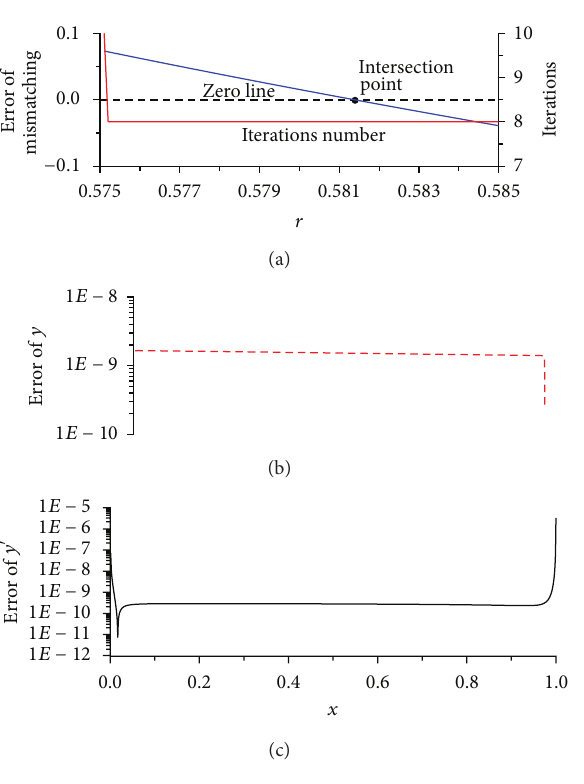
Figure 3: Example 2 solved by the SL (3, R ) method, (a) showing the error of mismatching and iterations number and showing the numerical errors (b) of 𝑦 and (c) 𝑦 󸀠